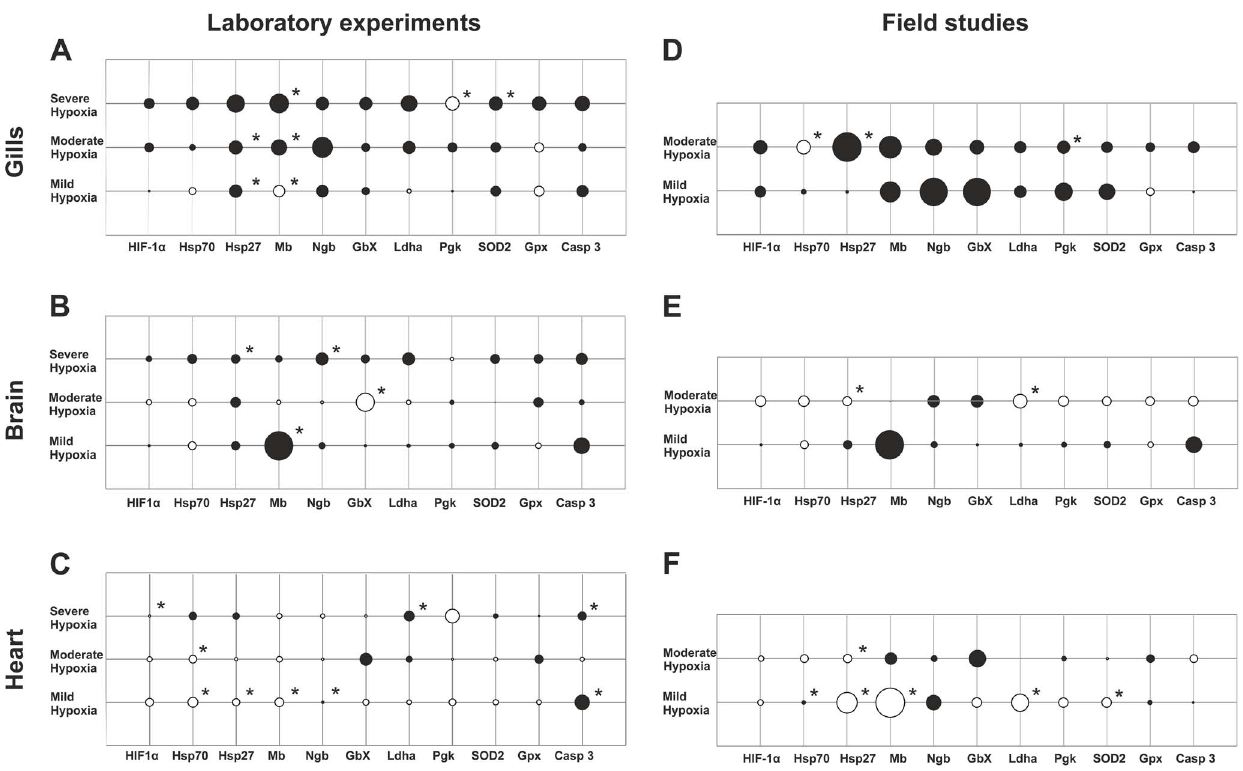
Figure 3. Bubble charts of relative expression patterns of putatively hypoxia responsive genes in ruffe under different hypoxic conditions in laboratory experiments (A, B and C) and in the Elbe estuary (C, D and E). Evaluation of qRT-PCR results was performed with DD CT method by use of RPLP0 as a reference gene. All results of relative expression levels are represented in log base 2. The diameter of bubbles indicates the magnitude of gene expression. Black bubbles represent expression levels . 0, pen bubbles represent expression levels , 0, and crossing lines without a bubble signify no change in the expression level. Asterisks indicate significance at p , 0.1. We analysed the expression pattern in three tissues of ruffe: (A) and (D) gills, (B) and (E) brain and (C) and (F) heart. For more details see Table S2.